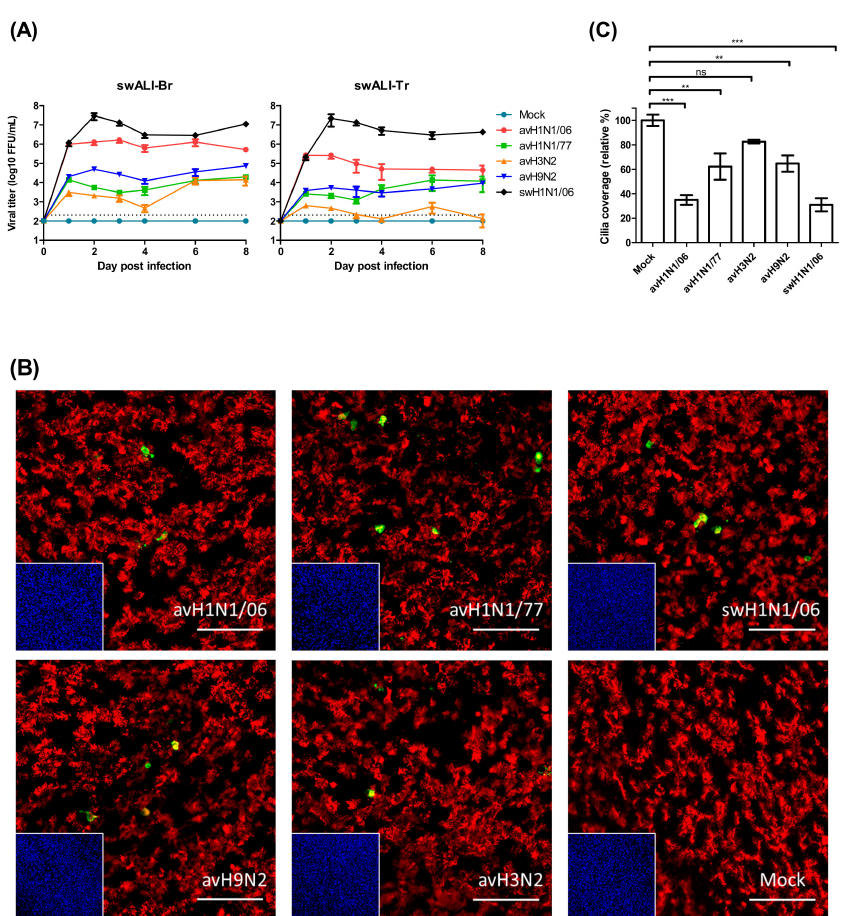
Figure 1. Avian influenza viruses showed di ff erent patterns of infectivity on infected swine airway epithelial cell (swALI). ( A ) Primary bronchial epithelial cells (swALI-Br) and primary trachea epithelial cells (swALI-Tr) were infected by di ff erent subtypes of avian influenza A viruses (IAVs), including avH1N1 / 06, avH1N1 / 77, avH3N2 and avH9N2. The swH1N1 / 06 was included in the experiment to compare the infectivity and the pathogenicity. The apical inoculum was collected for eight days, and the titer of released infectious viral particles were measured by using focus forming assy. The dashed lines indicate detection limits for the assays. ( B ) Target cells of the avian influenza viruses were located by using immunofluorescence staining. Infected swALI were fixed at 12 h post infection to show the target cells of avian IAVs. Red: ciliated cells, Green: virus NP protein, Blue: nuclei, Yellow: colocalization. Scale bars, 100 µ m. ( C ) Detrimental e ff ect of avian IAVs on swALI. The cells were fixed at 8 days post infection to determine the loss of cilia after avian IAV infection. The average coverage of ciliated cells was measured by using ImageJ / Fuji and shown in bar chart; mock infected group was normalized to 100%. The results were shown as means ± SEM. ** p < 0.01 or *** p < 0.001 in one-way ANOVA with Tukey’s post-hoc test, respectively. ns denoted as not significant ( p >